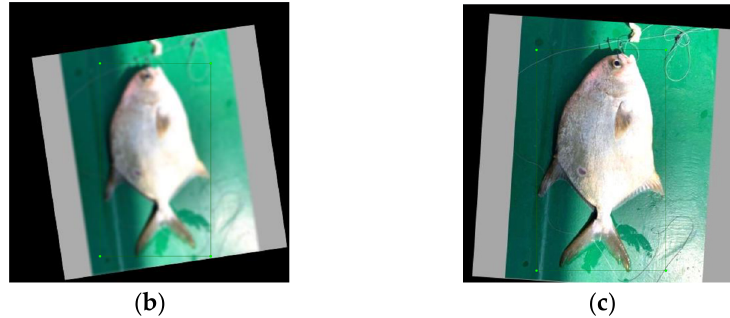
Figure 3. Data Augmentation ( a ) the original image; ( b , c ) the data augmented